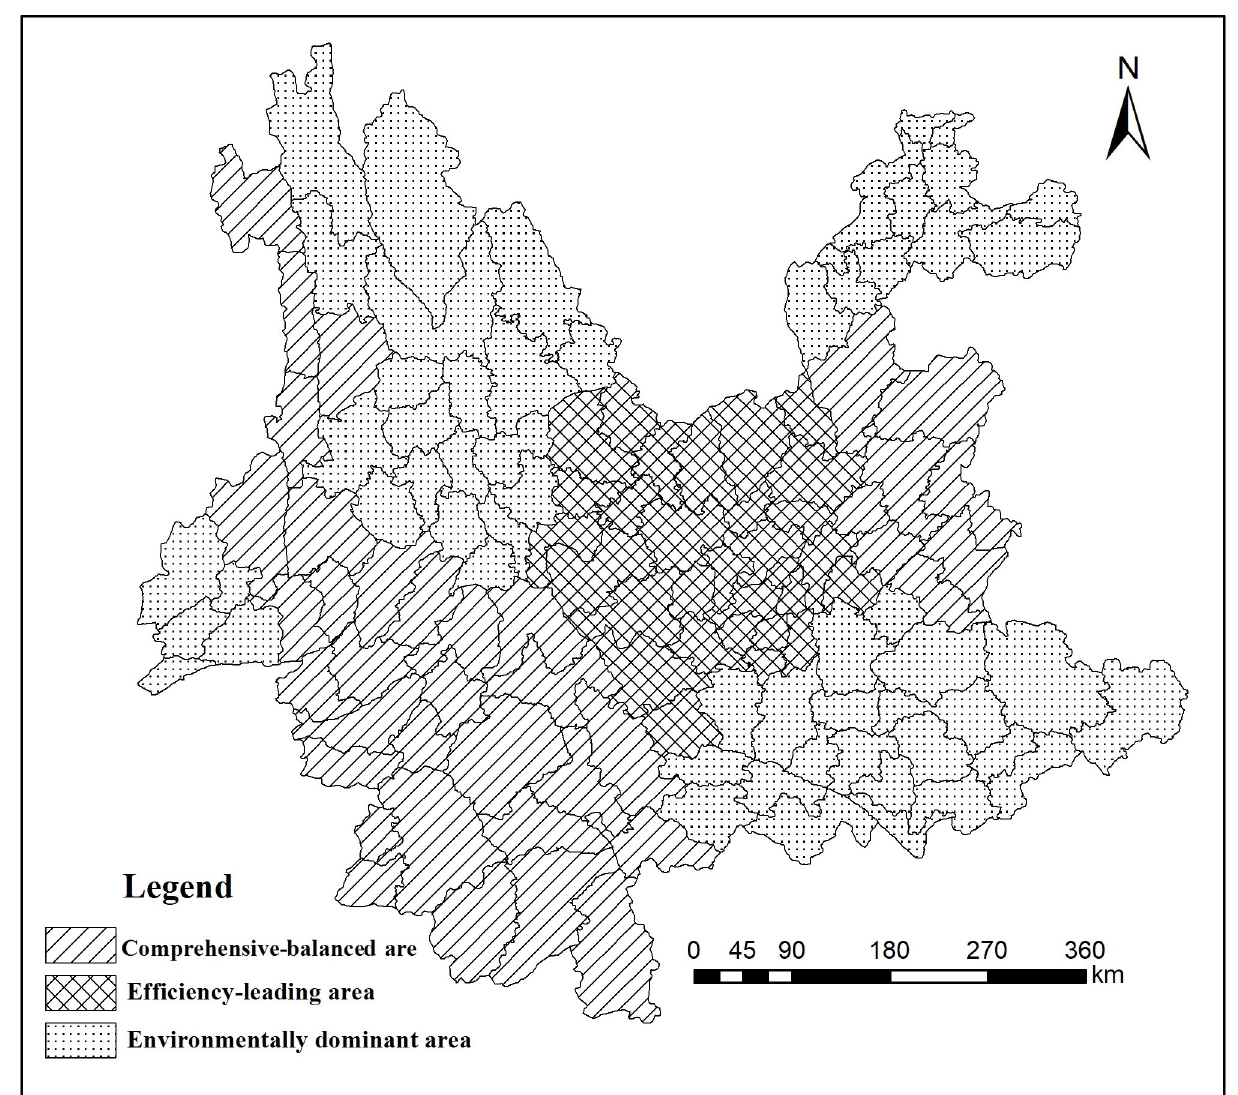
Fig 7. Ecological environmental zoning in Yunnan